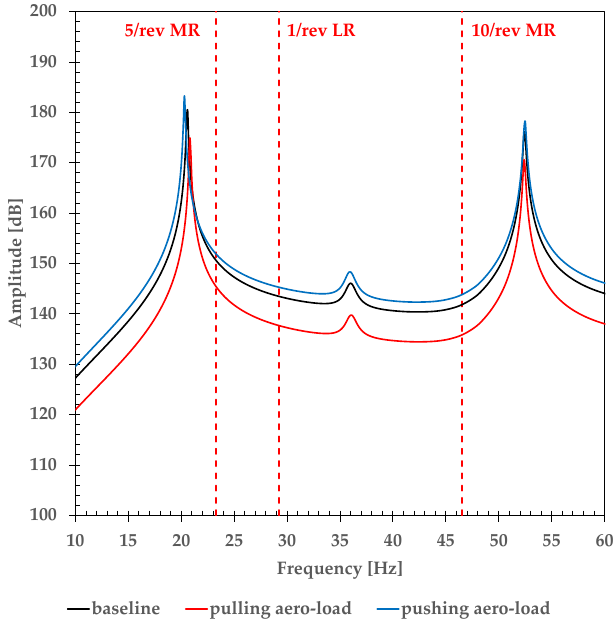
Figure 14. Aerodynamic preload effect on the dynamic transfer function.